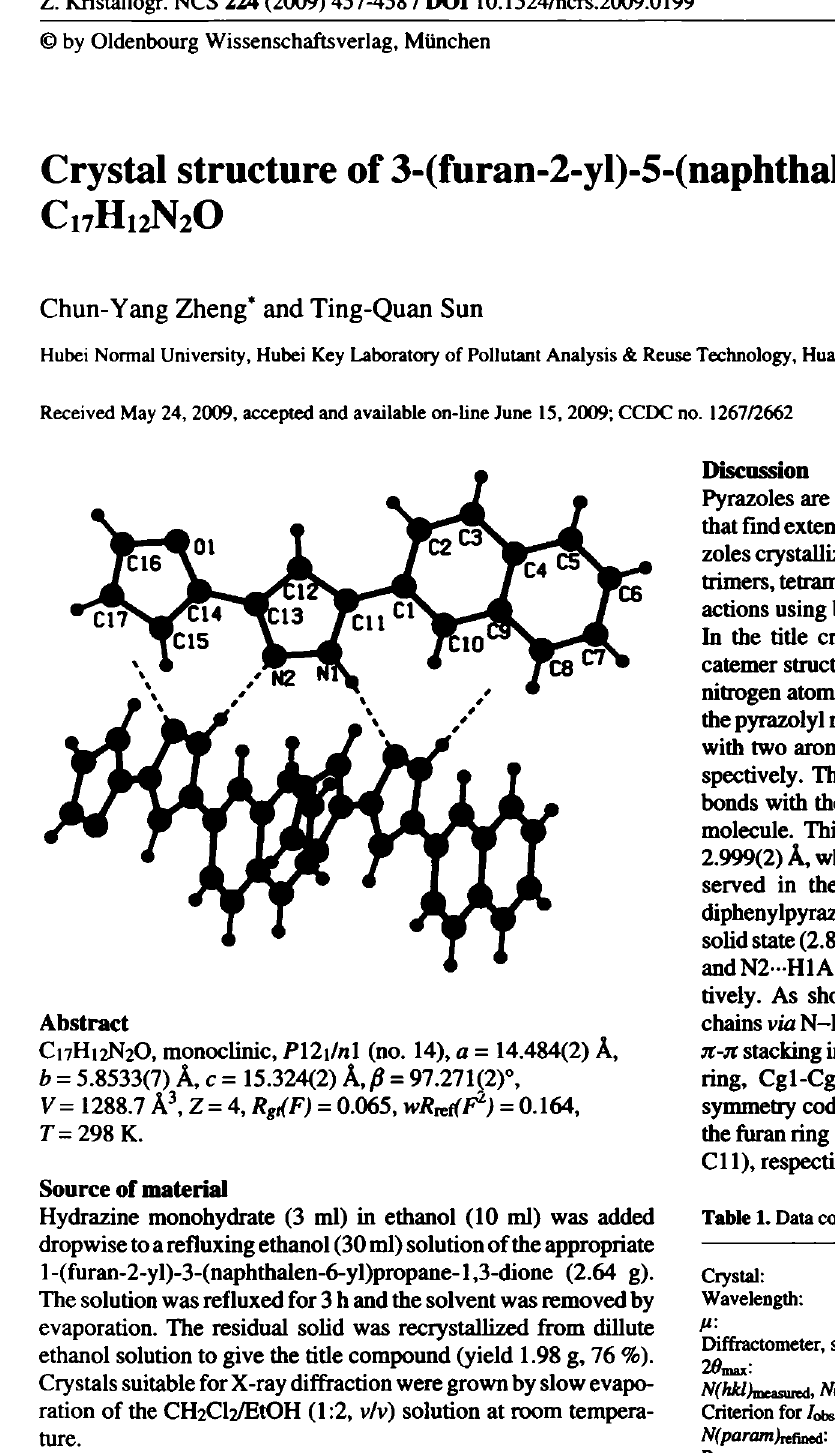
Table 2. Atomic coordinates and displacement parameters (in Â 2